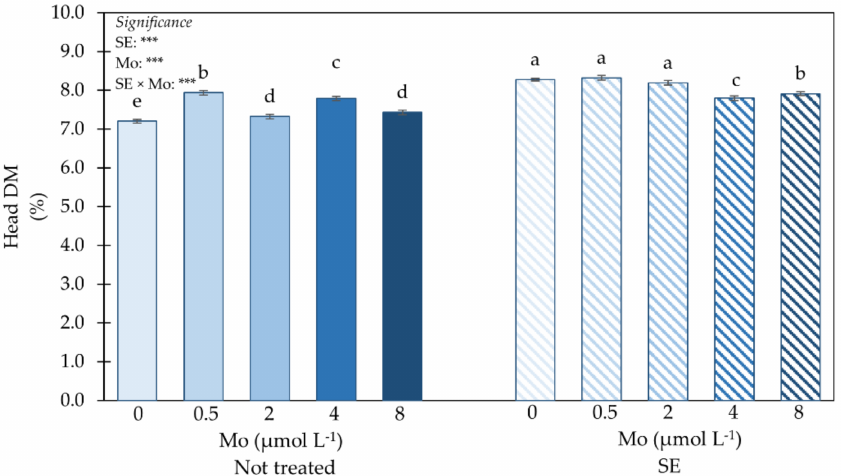
Figure 2. Impact of SE application and Mo-biofortification on head dry matter (head DM) of spinach plants cultivated in a protected environment. Values with diverse letters significantly differ at p ≤ 0.05. *** significant at 0.001. Bars indicate mean ± standard error of 3 replicates of 5 samples. Plants treated with SE and supplied with Mo at 0, 0.5 or 2 µ mol L − 1 had the highest head DM, followed by those untreated with SE and supplied with 0.5 µ mol Mo L − 1 and by those treated with SE with the highest Mo dosage (Figure 2). Untreated plants exhibited the lowest head DM (0 mL SE L − 1 × 0 Mo µ mol L − 1 ). The current study also investigated the impact of Ecklonia maxima SE and Mo treat- ments on color parameters, soluble solids content (SSC), ascorbic acid, polyphenols and carotenoids. Statistics on these parameters indicated no significant interaction between SE × Mo. Treatments had no significant effect on either CIELab parameters or on SSC (Table 2). Table 2. Effect of SE application and Mo-biofortification on CIELab parameters (a*, b* and L*), soluble solid content (SSC), ascorbic acid, polyphenols and carotenoids of spinach plants cultivated in a protected environment.